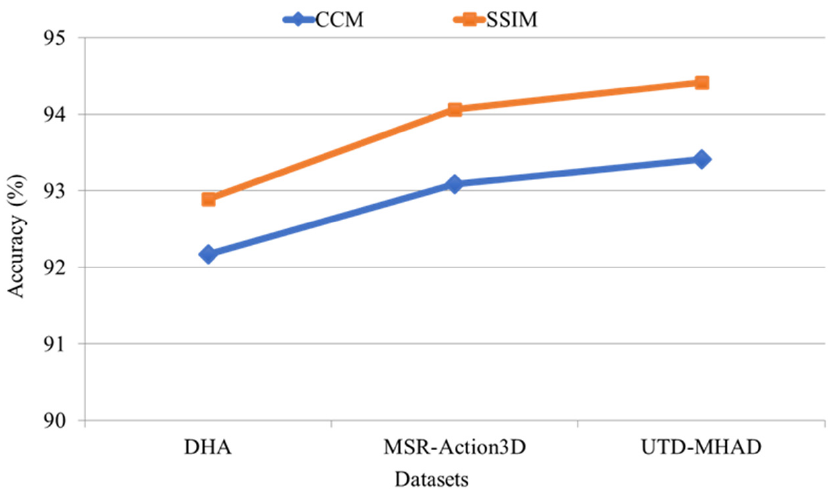
Figure 11. Summarizations of recognition results for ranking metrics and three datasets.